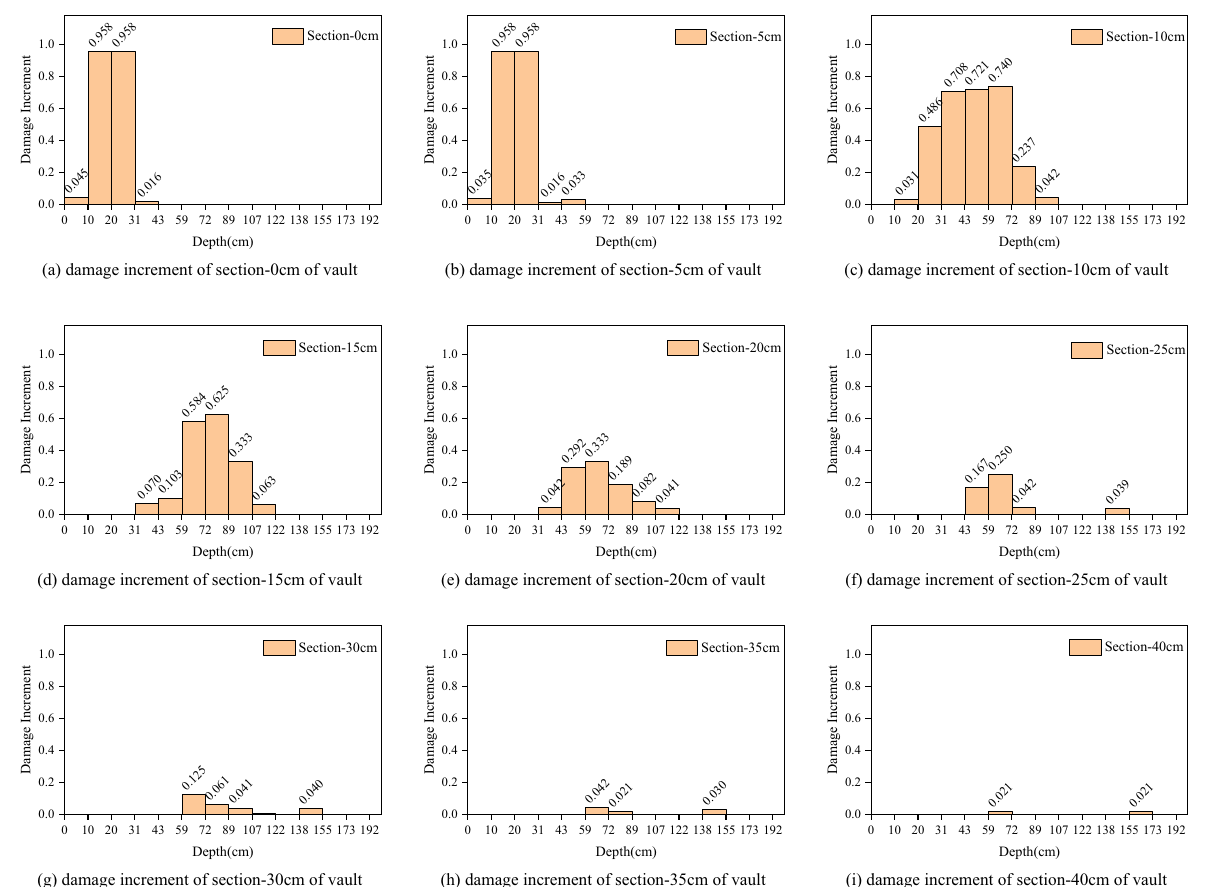
Figure 17. Damage increment distribution along the depth of surrounding rock in different sections of